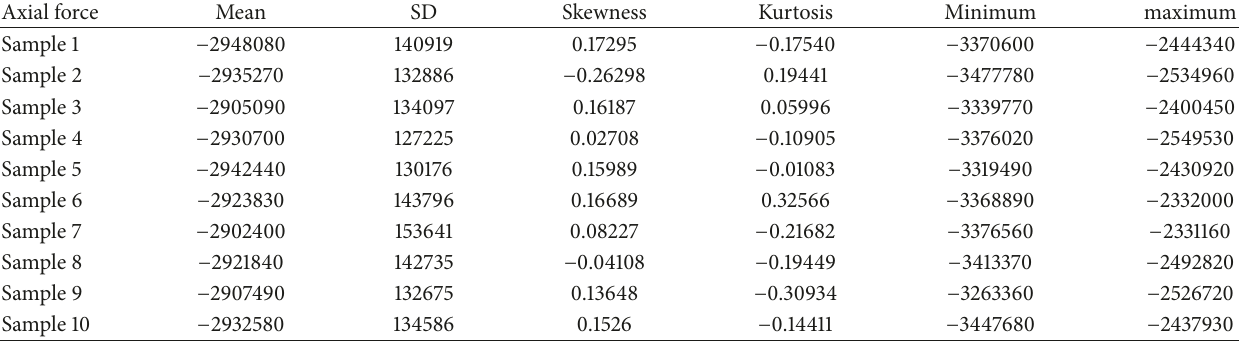
Table 9: Statistics of 10 samples parameters of the single high tower element 1972# axial force time history under wind field 2 (N).